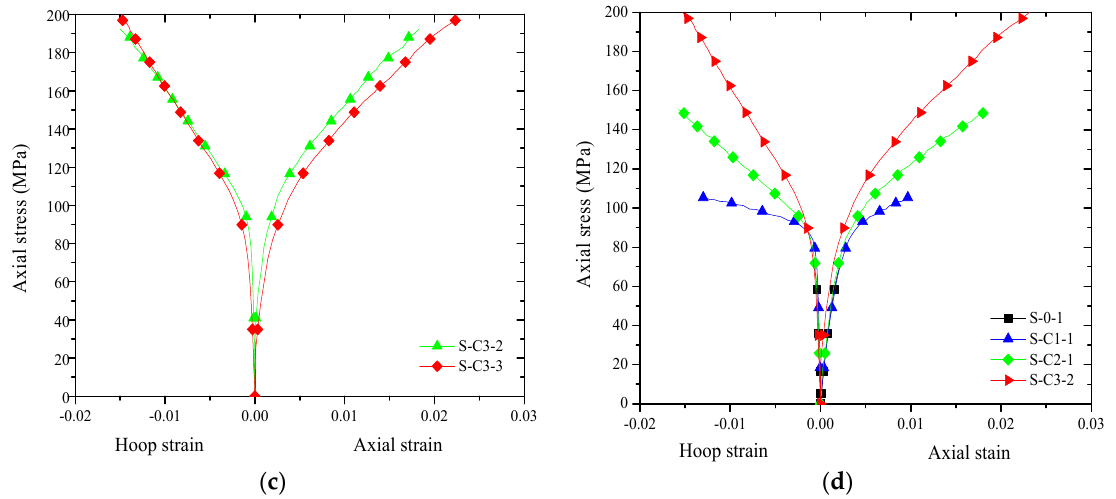
Figure 7. Stress–strain curves of the CFRP-confined concrete specimens under quasi-static compression. ( a ) One-layer CFRP-confined specimens; ( b ) Two-layer CFRP-confined specimens; ( c ) Three-layer CFRP-confined specimens; and ( d ) CFRP-confined and unconfined specimens.